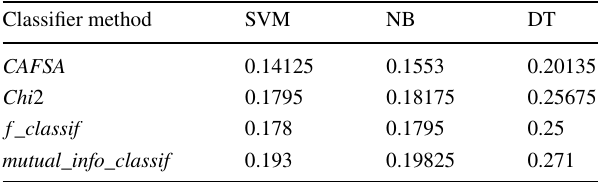
Table 10 Classic feature selection method and CAFSA experimental results on ChnSenticorp_NoteBook dataset